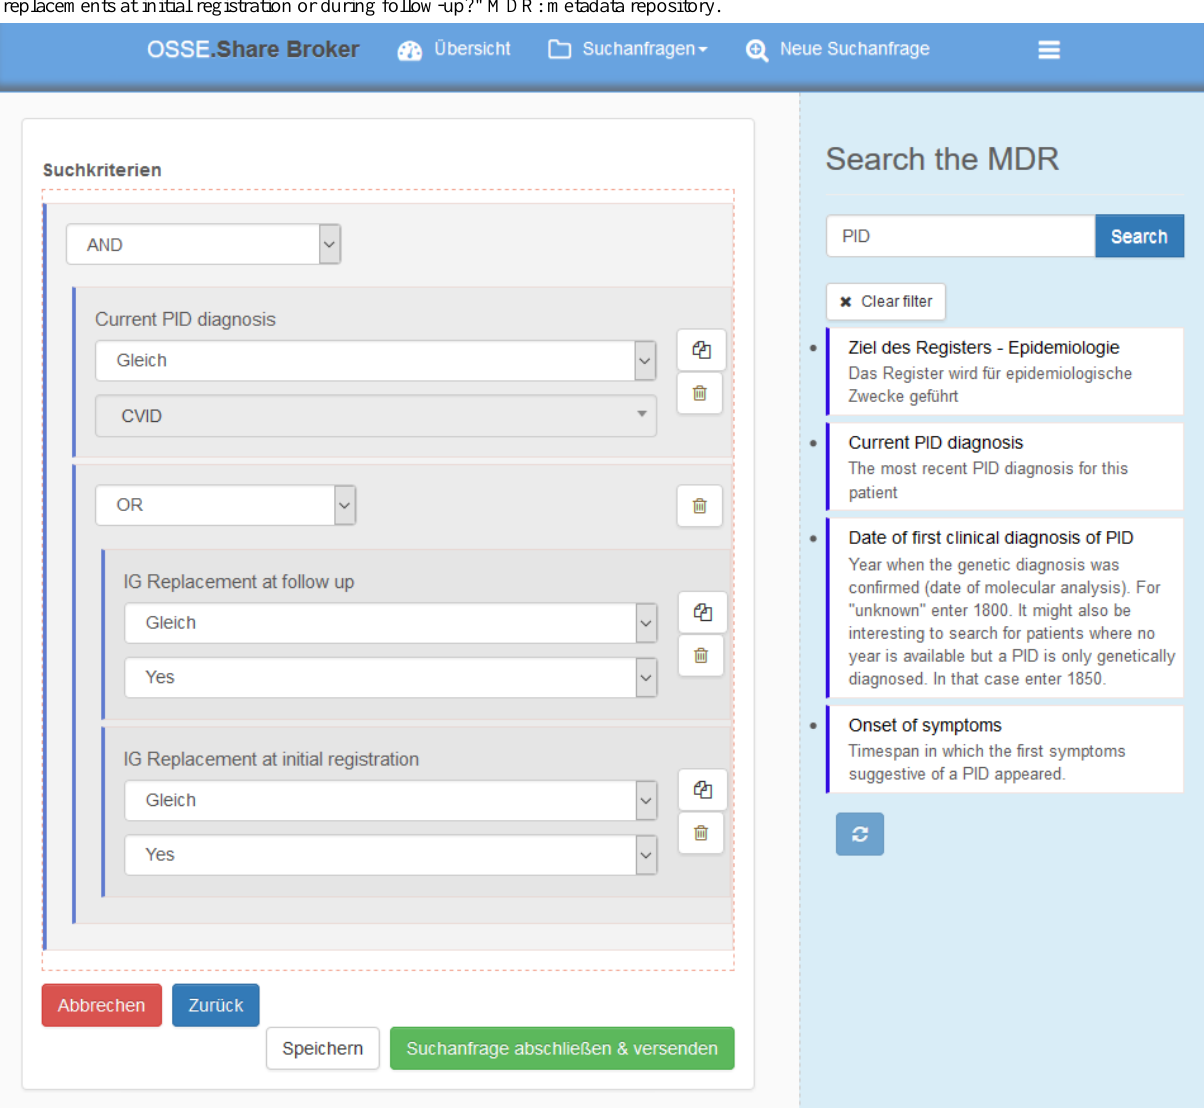
Figure 4. The graphical implementation of the second question requires nested constraints. The second question is "Which patients have a common variable immunodeficiency (CVID) as their most recently documented primary immunodeficiency (PID) diagnosis, or are still receiving immunoglobulin (Ig) replacements at initial registration or during follow-up?" MDR: metadata repository.